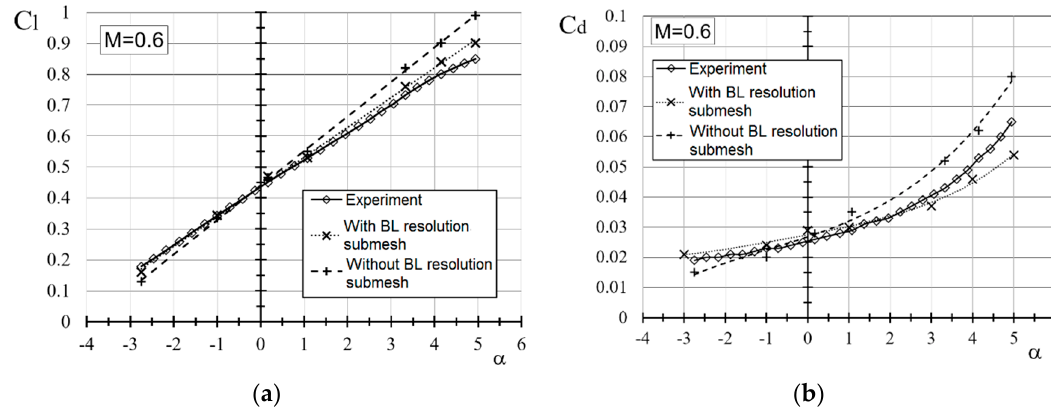
Figure 4. Comparison of computed DLR-F4 lift ( a ) and drag ( b ) coefficients with AGARD wind tunnel experiment results at M = 0.6 and Re = 3 × 10 6 using a mesh with an inflated boundary layer resolution submesh and without it. (AGARD: Advisory Group for Aerospace Research and Development)